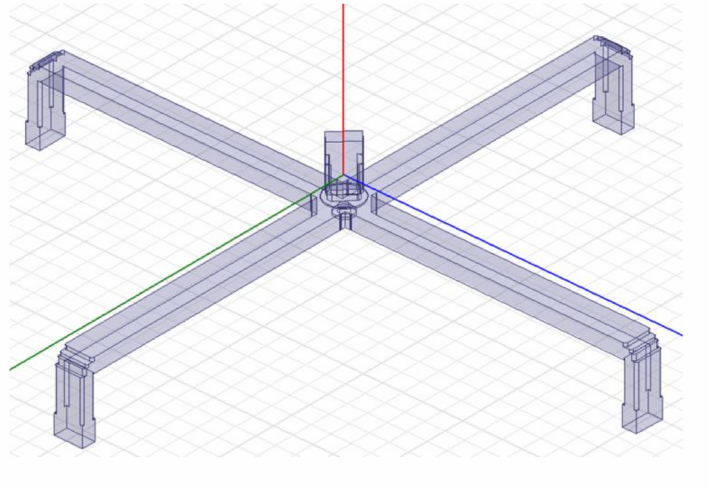
Figure 6. Power divider structure as simulated in ANSYS